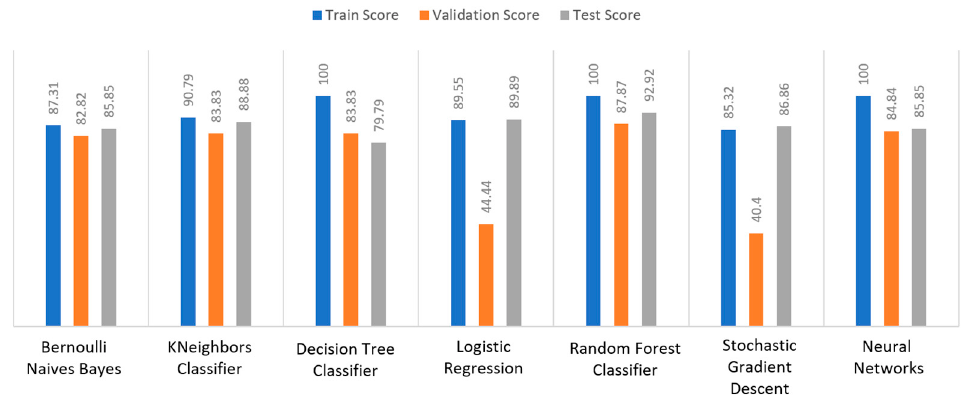
Figure 24. Train–validation–test score for COVID-19 use case.